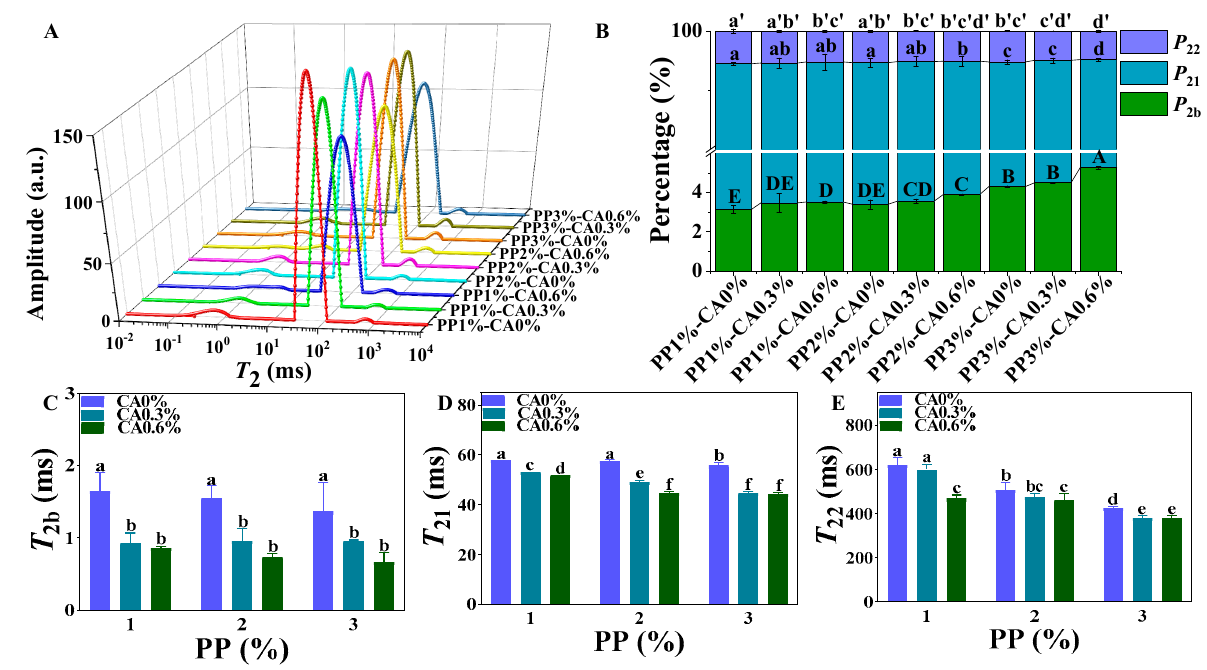
Figure 8. LF-NMR results of the restructured mackerel mince 3D-printing product before heat treatment: ( A ) is moisture distribution of the restructured mackerel mince 3D-printing product, ( B ) is the P 2b , P 21 , and P 22 of the restructured mackerel mince 3D-printing product (A–E, a–d, and a’–d’ represent the significance of P 2b , P 21 , and P 22 , respectively), and ( C – E ) are the T 2b , T 21 , and T 22 of the restructured mackerel mince 3D printing product; different marked letters in each figure indicate statistically significant differences in data in the figure ( p < 0.05).